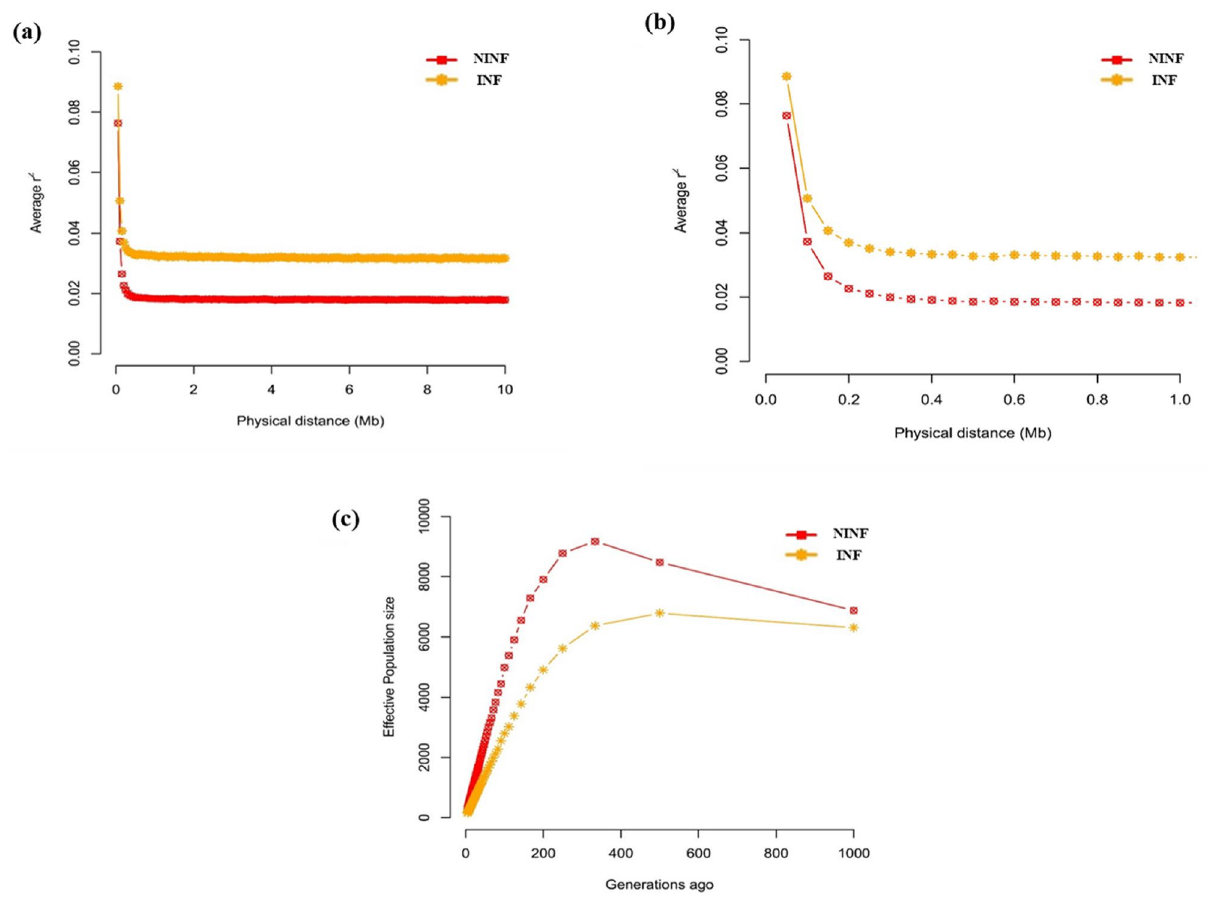
Figure 1. Trends in LD decay ( a , b ) and N E across 1000 generations ( c ) in non-infected and infected cohorts of autochthonous Tunisian sheep. INF infected cohort; NINF non-infected